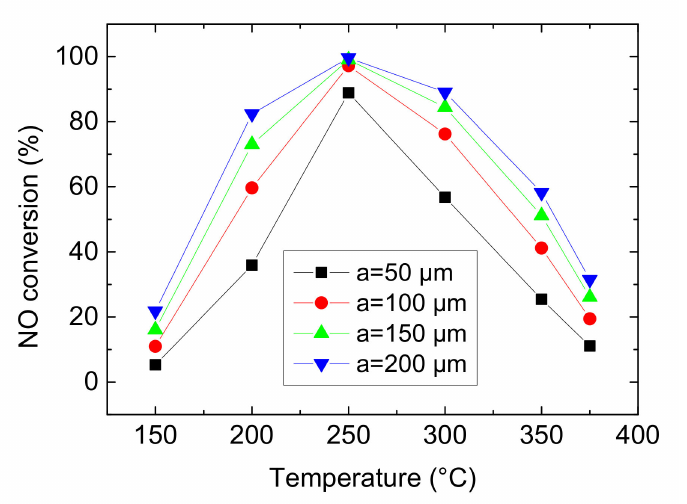
Figure 12. Effect of wall thickness of channels on NO conversion (Concentration C NH3 = C NO = 750 ppm, C O2 = 6%, without H 2